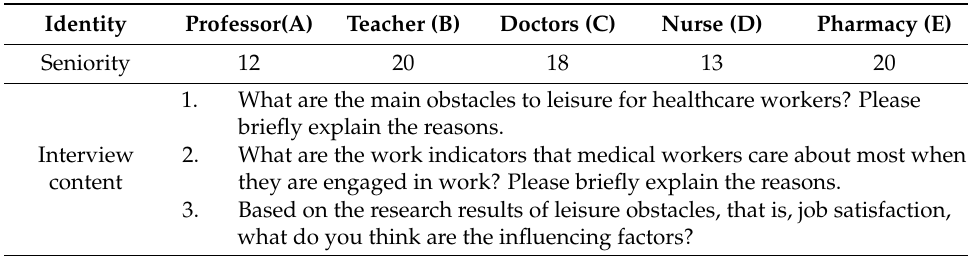
Table 7. Background of the interviewees and content of the